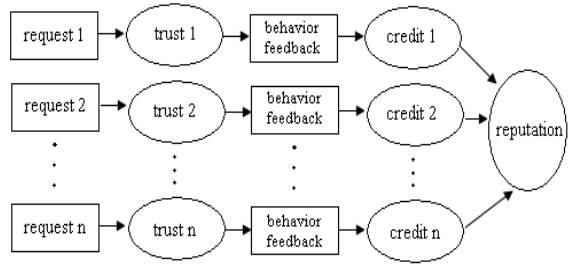
Fig. 1. Relationship among trust, credit and